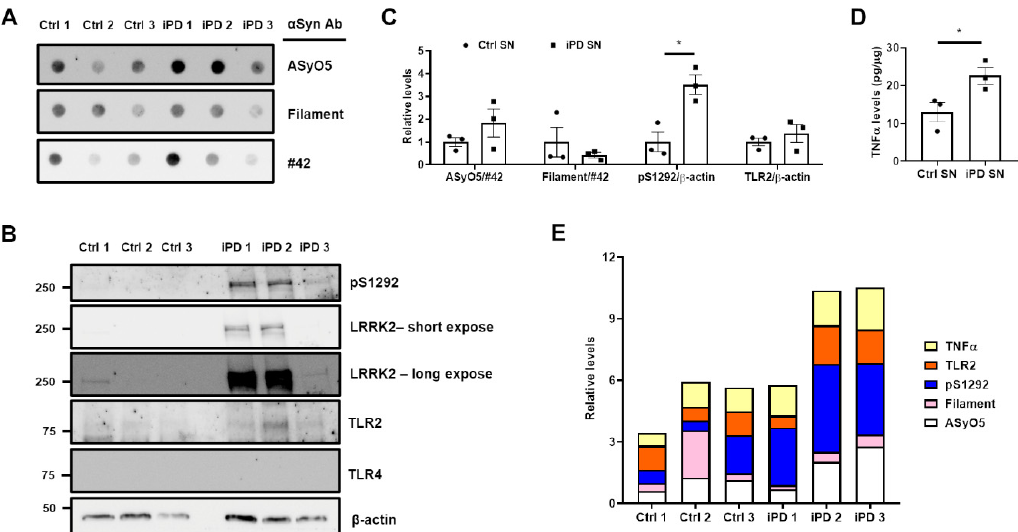
Figure 8. Post-mortem analyses of substantia nigra lysates form human patients. The SN lysates were subjected to ( A ) dot blot (50 µ g of each lysate) and ( B ) Western blot (20 µ g of each lysate) analyses, and membranes were analyzed using indicated antibodies. ( C ) The relative levels of oligomeric α Syn (normalized to #42 α Syn) and pS1292 or TLR2 (normalized to β -actin) in the SNs of control patients (Ctrl SN, circle) and idiopathic PD patients (iPD SN, square) were analyzed. ( D ) TNF α levels in SN lysate were measured using a human TNF α ELISA kit. ( E ) All relative data were aligned in a personal number. The colors indicate the following: yellow, TNF α ; orange, TLR2; blue, pS1292; pink, Filament α Syn oligomer; white, AsyO5 α Syn oligomer. * p < 0.05. All data are represented as the mean ± SEM.